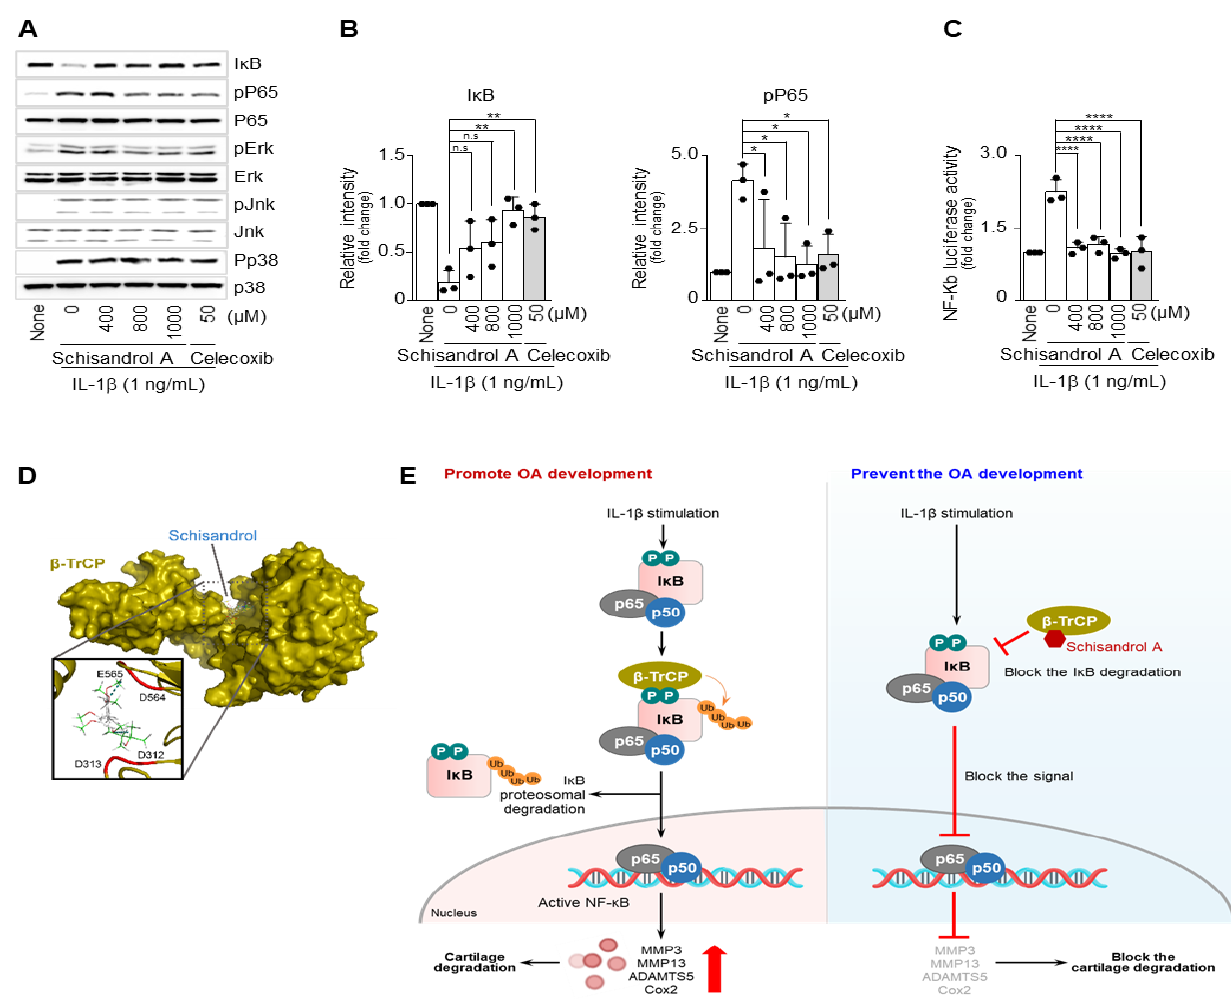
Figure 4. Schisandrol A regulates IL-1 β -induced NF- κ B activation. Mouse articular chondrocytes were pretreated with Schisandrol A at different concentrations for 24 h ( n = 3) before being treated with IL-1 β (1 ng/mL) for 15 min. ( A ) Protein levels of I κ B and phosphorylated p65 (pp65), phosphorylated JNK (pJNK), phosphorylated ERK (pERK) and phosphorylated p38 (pp38) were evaluated by Western blotting. ( B ) Protein levels of I κ B and phosphorylated p65 (pp65) were evaluated using densitometry. Extracellular signal-regulated kinase (ERK) and p65 were used as loading controls. NF- κ B transcriptional activity ( C ) was assessed using a luciferase reporter gene assay. ( D ) Interaction simulation of Schisandrol A and β -TrCP generated by Autodock Vina program. ( E ) General summary of our findings. Celecoxib (50 µ M) was used as a positive control. Data were analyzed using one-way ANOVA with Bonferroni’s test, and the plotted values were expressed as means ± SEM; n.s. p > 0.05, * p < 0.05, ** p < 0.01 and **** p < 0.0001 compared to the control group.